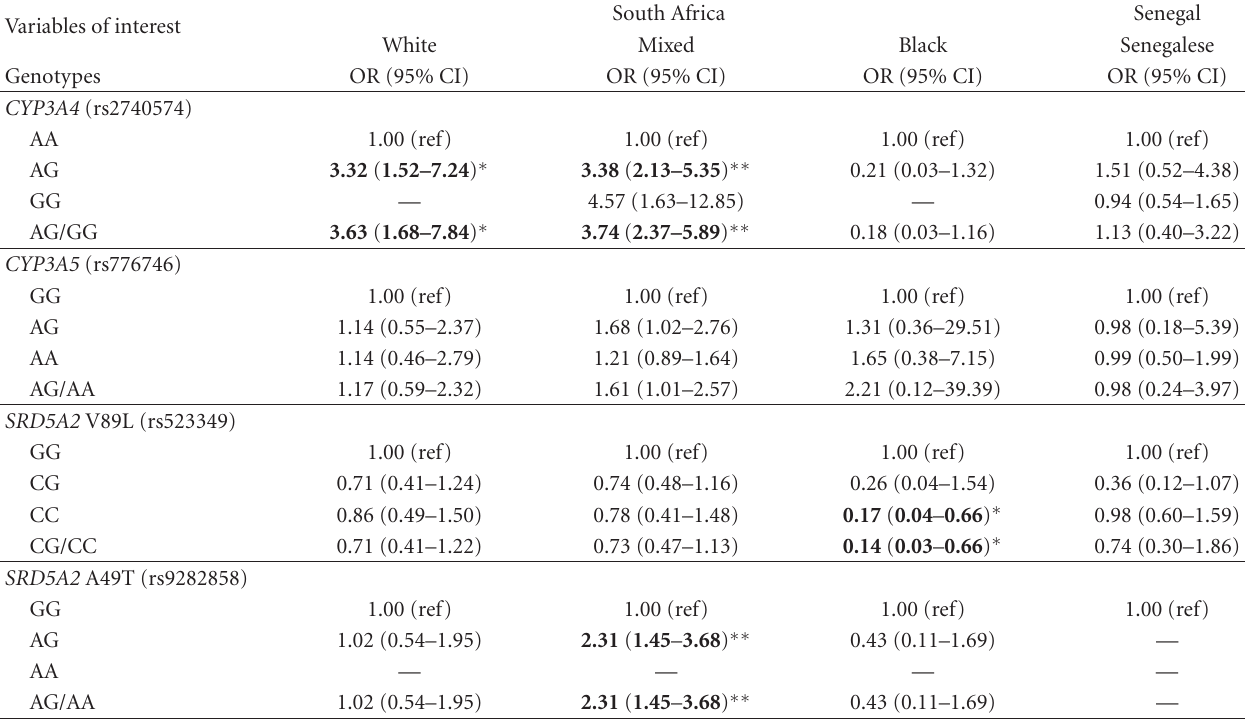
Table 3: South African and Senegalese case-control genotype associations with prostate cancer (adjusted for age). Variables of